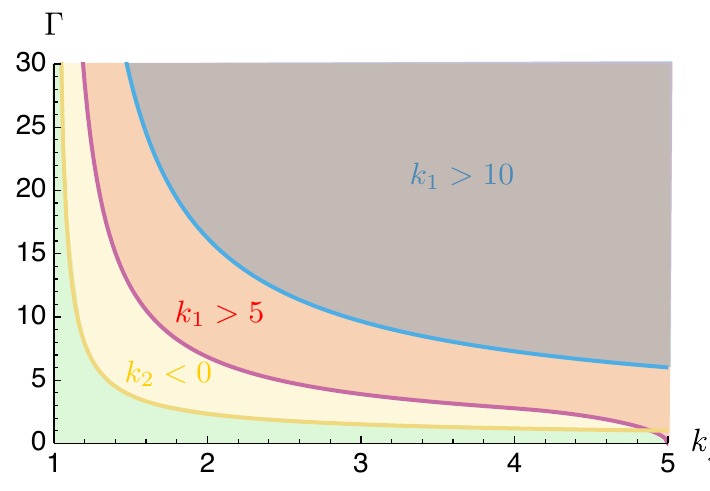
Figure 7: Experimental limits of the coupled ESE protocol in terms of the speed-up pa- > 1). The yellow line represents rameter Γ for a compression of the first particle ( k f > 0, the red one to maintain the higher limit Γ should not exceed to maintain k 2 < 5 and the blue one to maintain k < 10. The requirement k > 0 being the k 1 1 2 most restrictive, the limit to respect during experiments is the yellow line that corre- sponds to Γ . In other words, the working region where all the constraints are met lim ,1 is the green region. The yellow, red and blue regions delineate the domains where the respective requirements are not met